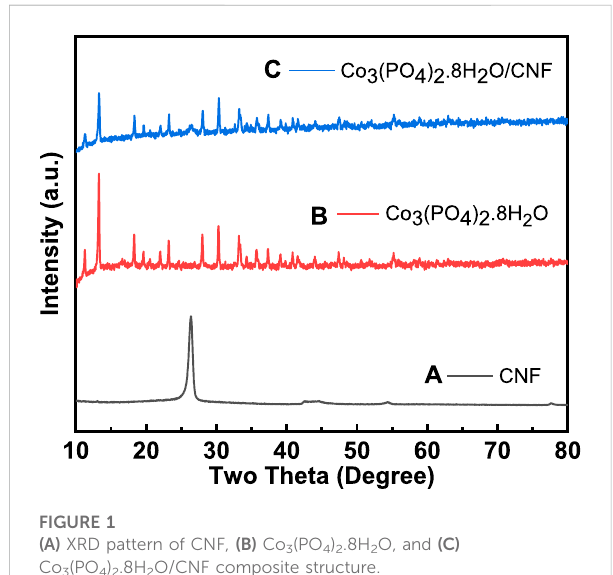
FIGURE 1 (A) XRD pattern of CNF, (B) Co 3 (PO 4 ) 2 .8H 2 O, and (C) Co 3 (PO 4 ) 2 .8H 2 O/CNF composite